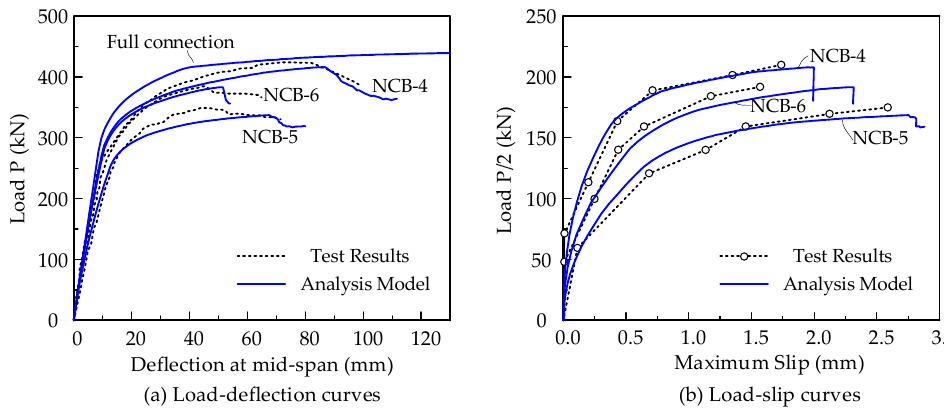
Figure 10. Comparisons of analysis results with tests of NCB-4, NCB-5 and NCB-6.